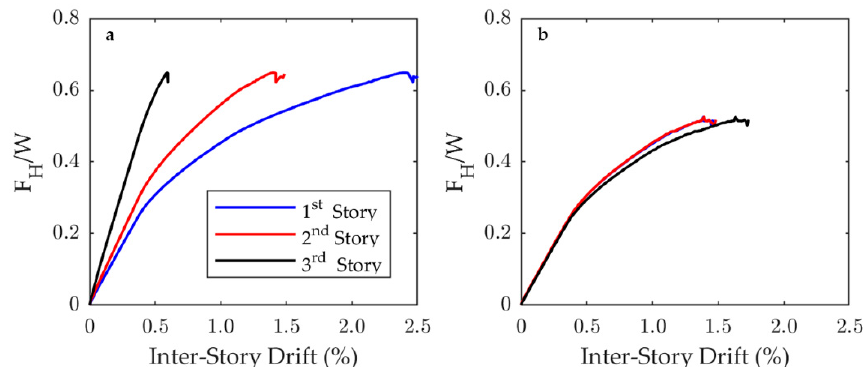
Figure 8. Pushover analysis results for the M3 model: ( a ) inter-story drift distribution with a constant lateral load capacity in height ( 𝛽 = uniform) and ( b ) with a load capacity proportional to the story force demand ( 𝛽 = variable).